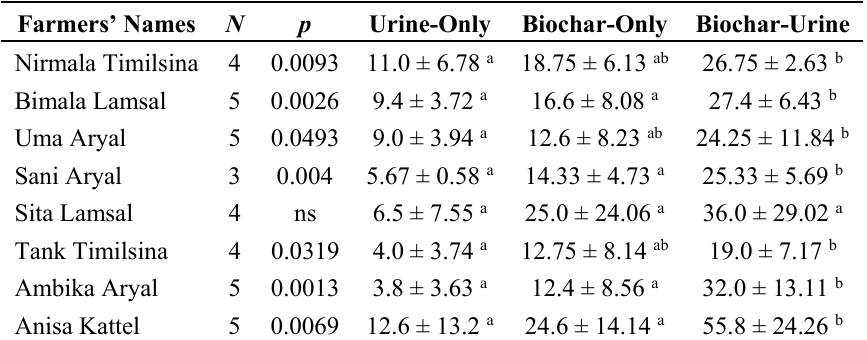
Table 3. Mean pumpkin yield of the eight individual trials.